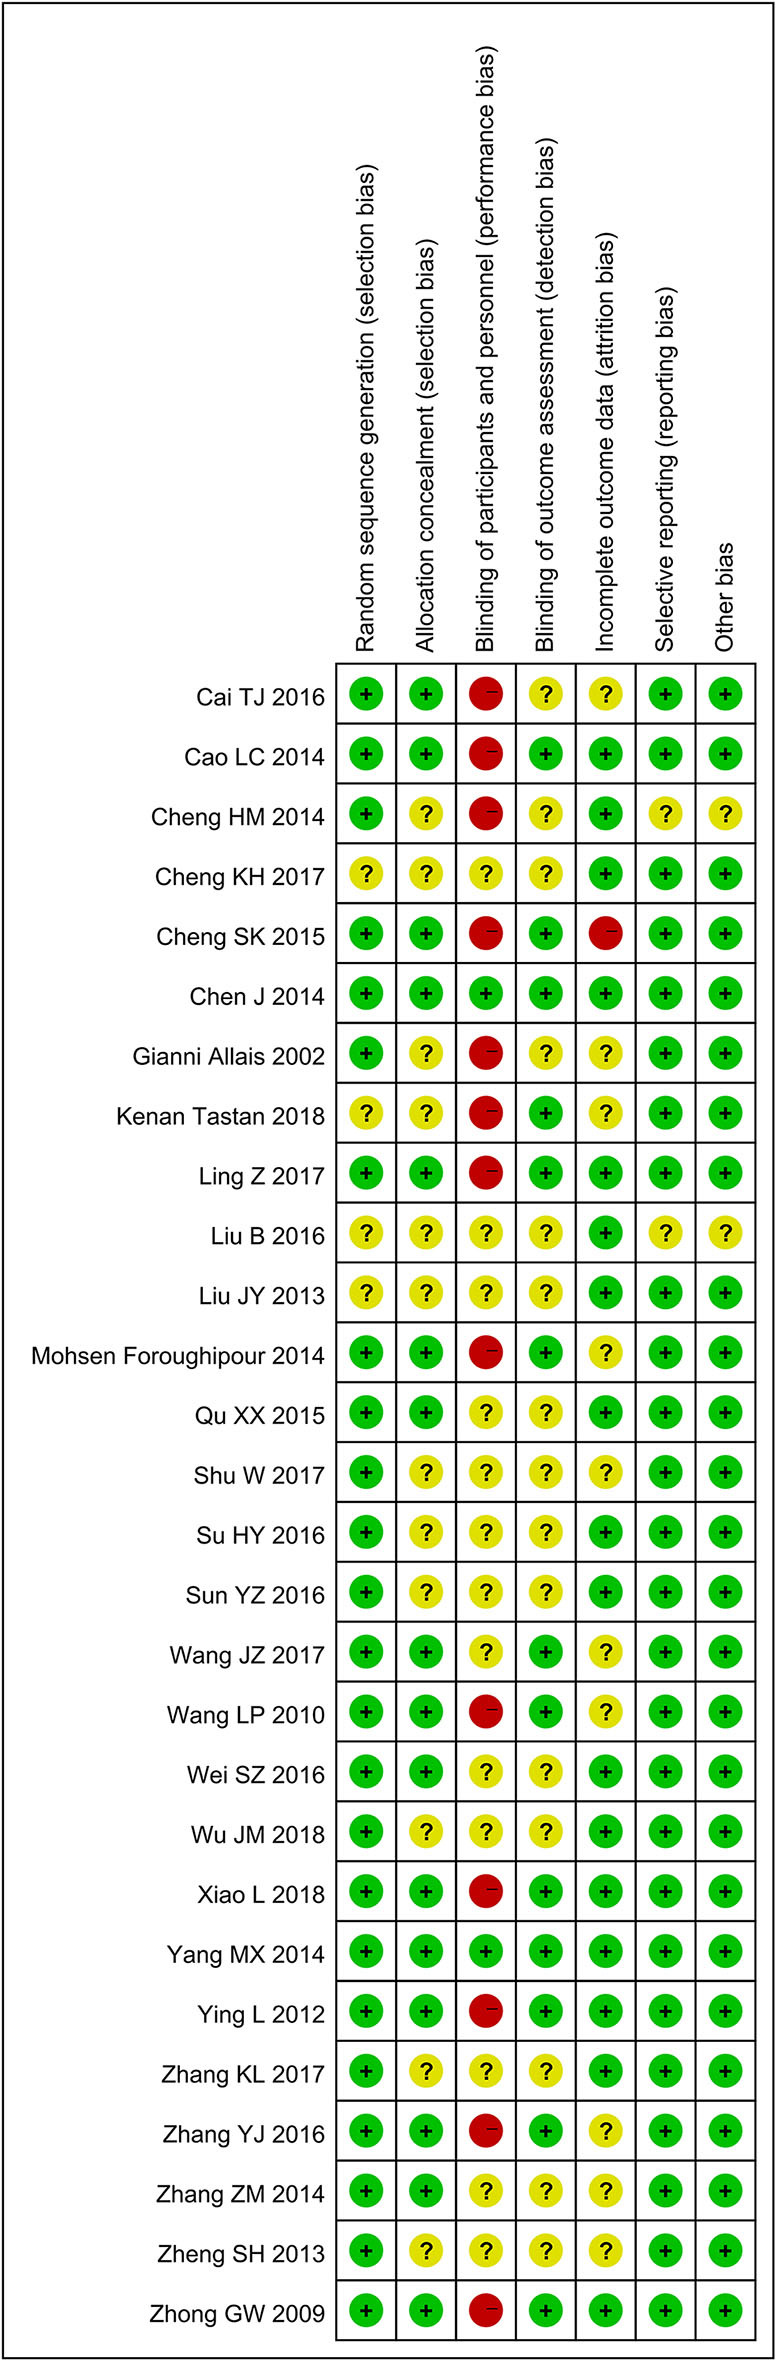
Bias risk summary map.